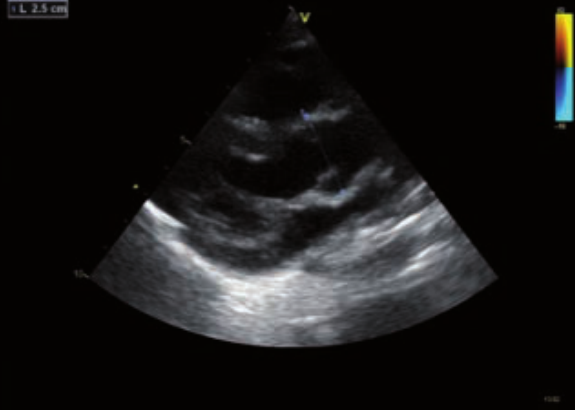
Figure 10. Mucopolysaccharidosis type I in a 5-year old girl. Dilatation of the aortic root.